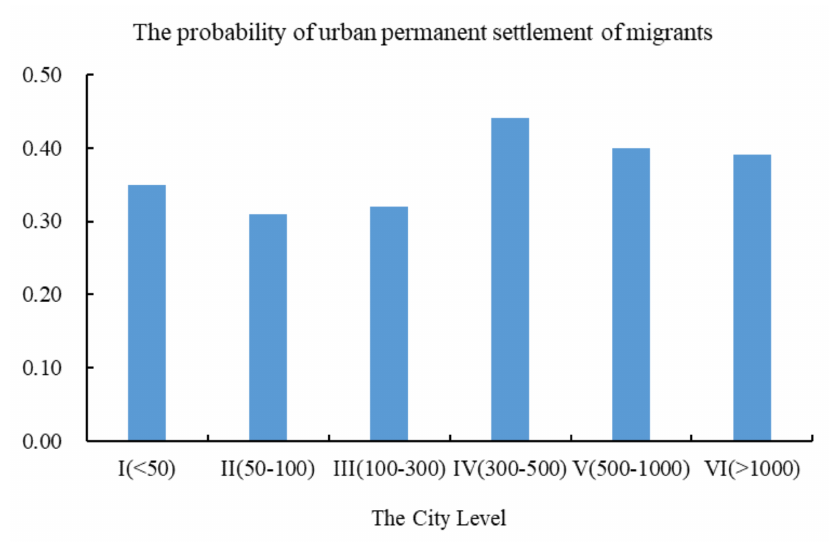
Figure 1. The spatial pattern of urban size in urban China.